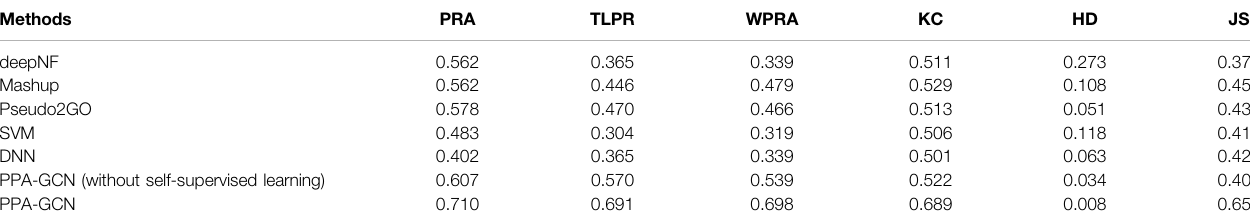
TABLE 2 | Performance comparison under 5-fold cross-validation Methods deepNF